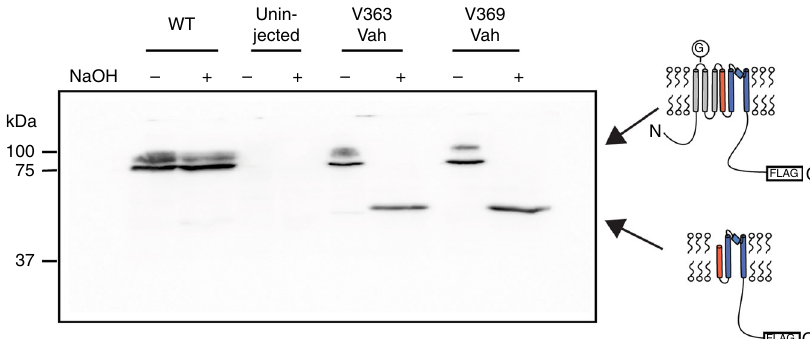
Fig. 2 Hydrolysis of α -hydroxy encoded channels. Western blot of crude membrane preps of oocytes injected as labeled. WT channels cannot be hydrolyzed by base (NaOH, see Methods), but V363Vah and V369Vah are cleaved at the ester bond with base addition. Full-length channels contain a conserved glycosylation site (G), producing a two-band pattern. Channels are detected with a C-terminal FLAG